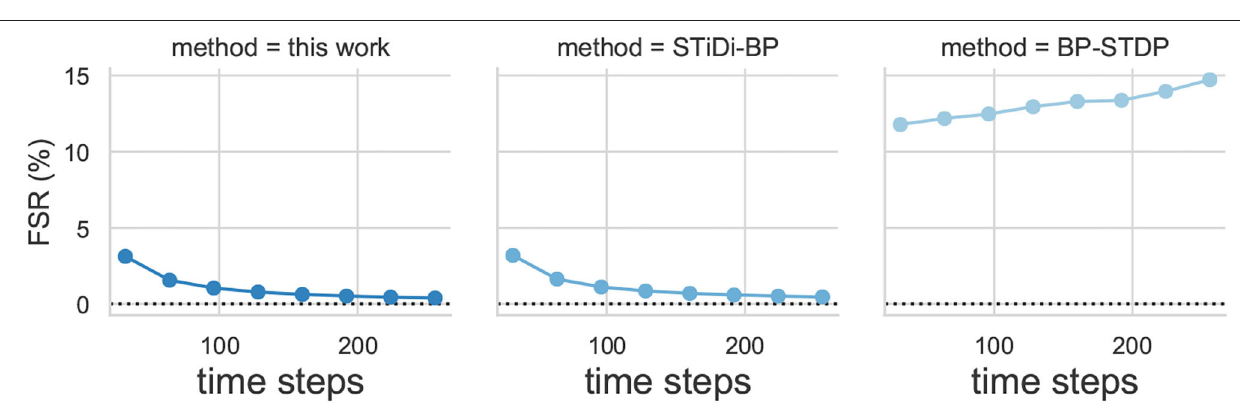
FIGURE 9 | The Inference computational cost (FSR) evolution curve comparisons between SSTDP and the two baseline SNNs (STiDi-BP and